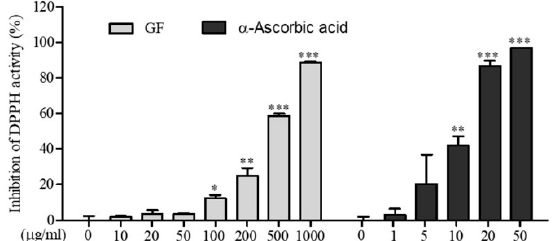
Figure 1. Antioxidant activity of Gardeniae fructus extract (GF). DPPH free radical scavenging activities of GF and of α -ascorbic acid. Data are presented as mean ± SEM. * P < 0.05, ** P < 0.01, and *** P < 0.001 compared to nontreated